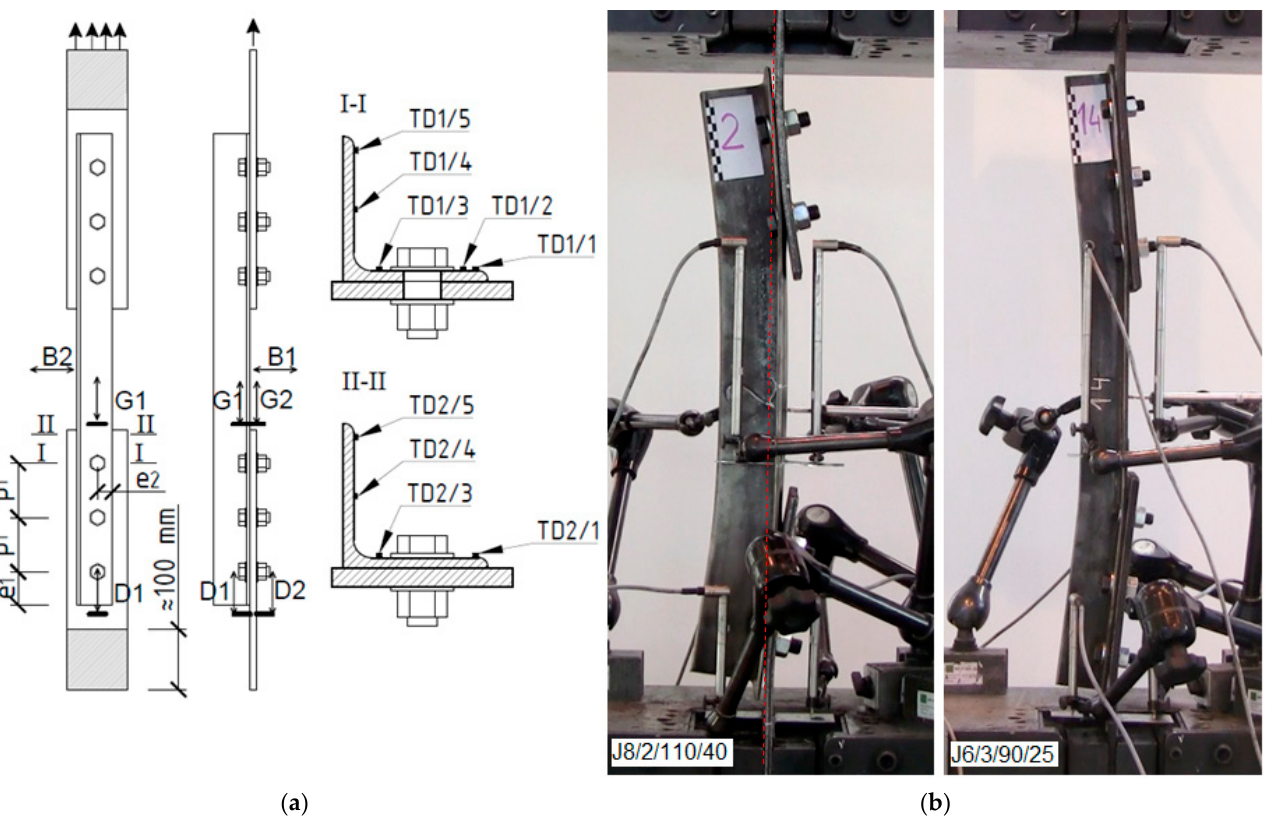
Figure 2. Test specimen: ( a ) placement of measuring devices, ( b ) test set-up. Fully threaded bolts (M16 and M20 class 8.8 or 10.9) were used. Normal round holes with a nominal clearance of 2.0 mm in accordance with EN 1090-2 [18] were applied to connect the angle and gusset plates at one end of the angle, at which failure was expected.